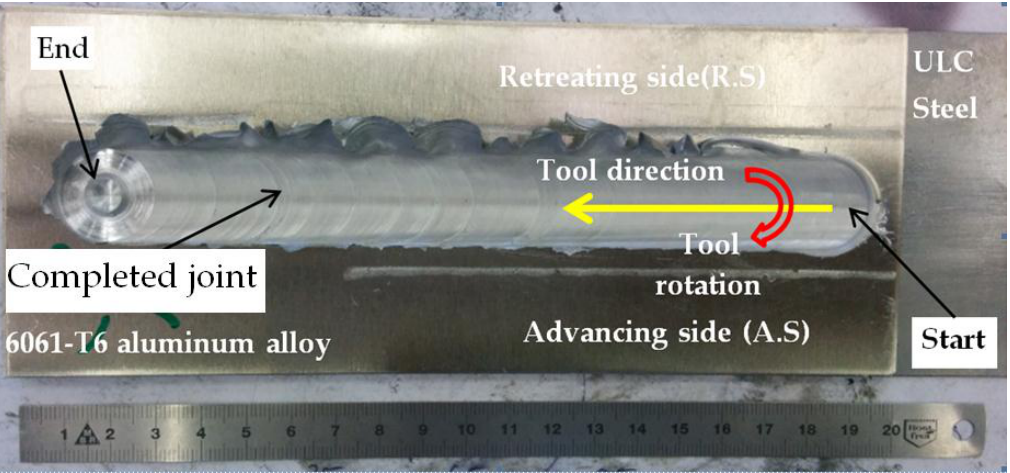
Figure 3. Macroscopic view of a completed joint. ULC: ultra-low carbon.